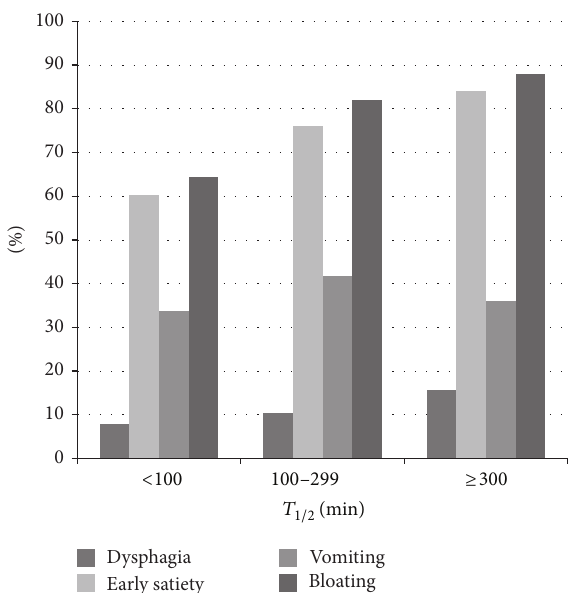
Figure 1: Prevalence of upper gastrointestinal tract symptoms in subjects undergoing gastric emptying scintigraphy.